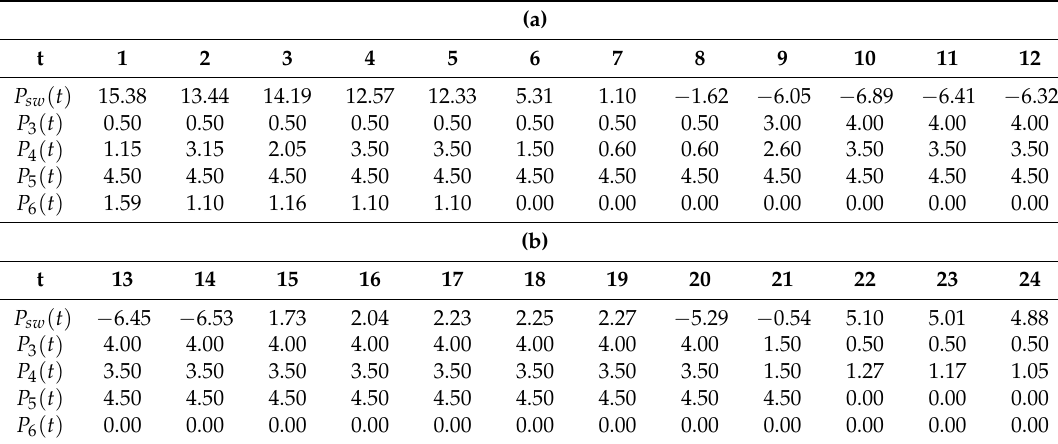
Table 5. ( a ) Expected values of real power injections (MW) during 1:00 a.m.–12:00 p.m. ( b ) Expected